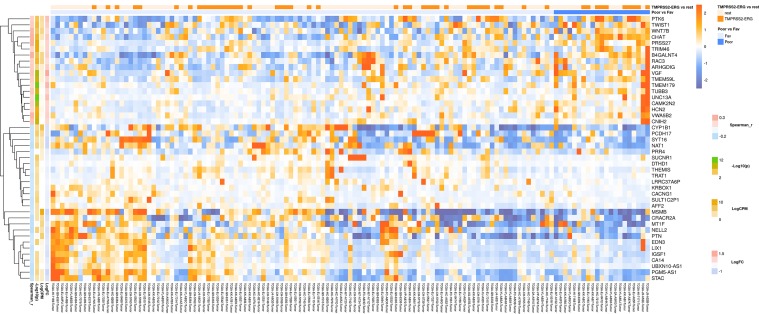
Heatmap demonstrating log relative expression level of top differentially expressed genes between the groups of adverse and favorable prognosis (TCGA data). Cell colors (blue-white-orange gradient) correspond the binary logarithm of the ratio of the expression level in a current sample to the average level across all the samples (per each gene). Blue - expression level is below the average, orange - above the average. Spearman_r—Spearman’s rank correlation coefficient. -Log10(p) is the negative logarithm of DESeq’s p-value. LogCPM—average binary logarithm of read counts per million (CPM). LogFC—binary logarithm of expression level fold change (samples with adverse prognosis compared to favorable prognosis).